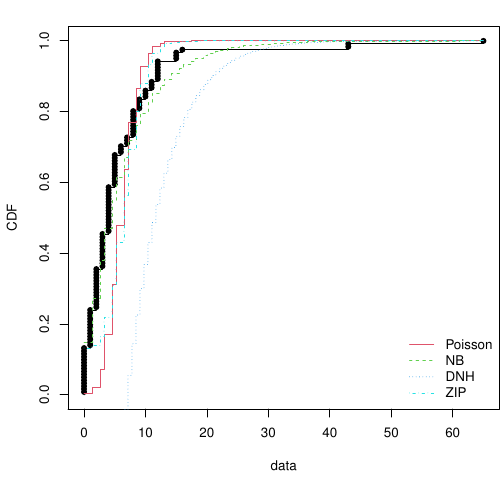
Figure 3 – Empirical CDF plot for the forest fire